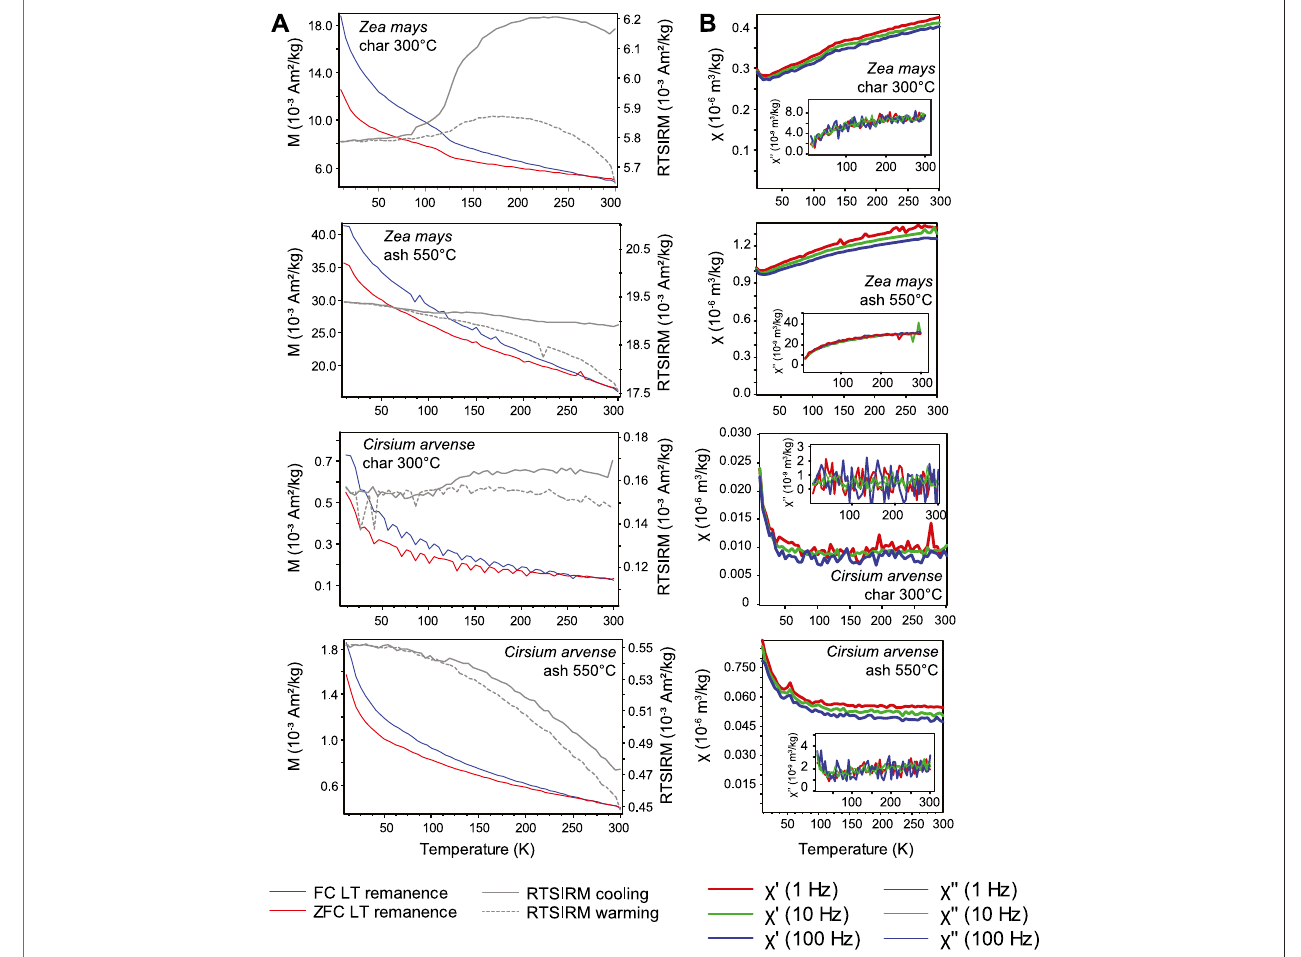
FIGURE 4 | Low-temperature frequency-dependent susceptibility measurements for (A) Icelandic litter and (B) Icelandic ash samples. Out-of-phase susceptibility measurements are shown in inset plots.